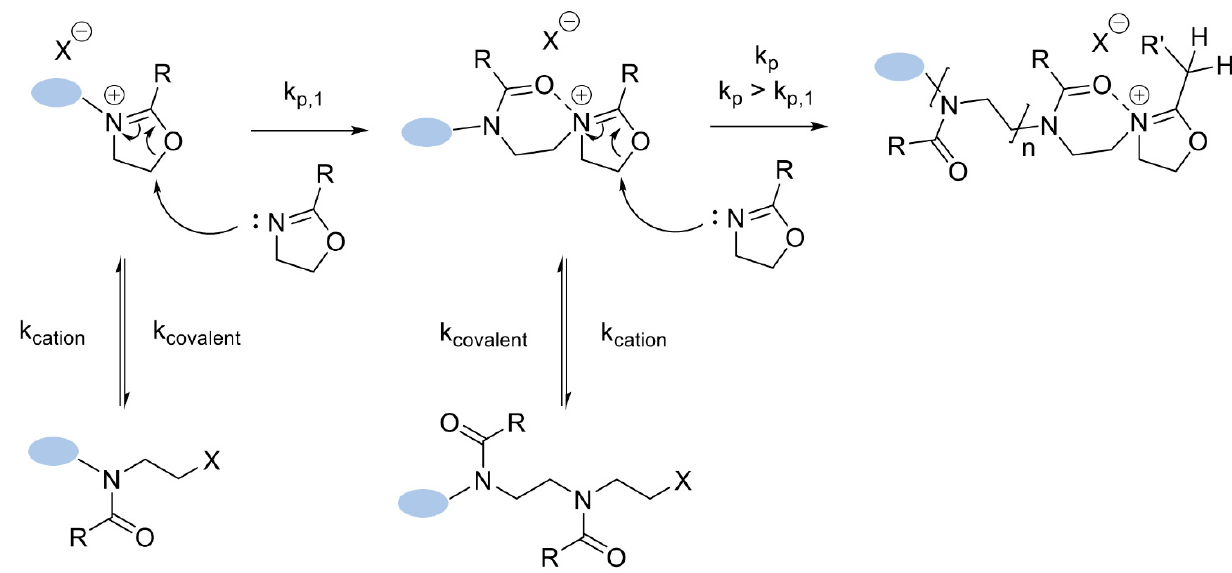
Figure 6. The propagation mechanism of the living cationic ring-opening polymerization (CROP) of 2-oxazoline monomers. Adapted from [12].